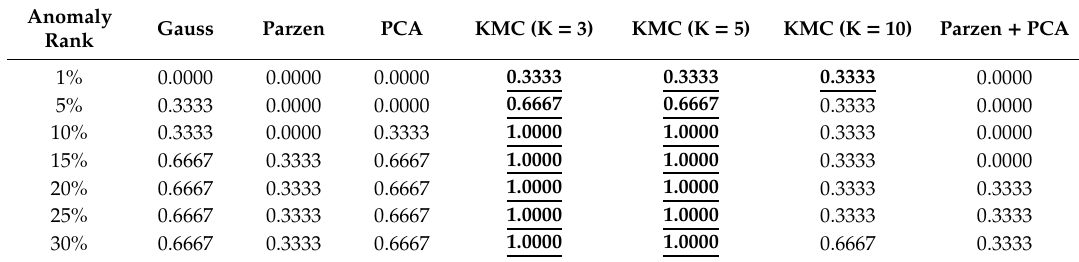
Table 19. True detection rate of each anomaly detection algorithm based on the e-mail communication network dataset (HIS1706). Best performance is shown in bold and underlined (number of normal behaviors in the test set: 493, number of malicious behaviors in the test set: